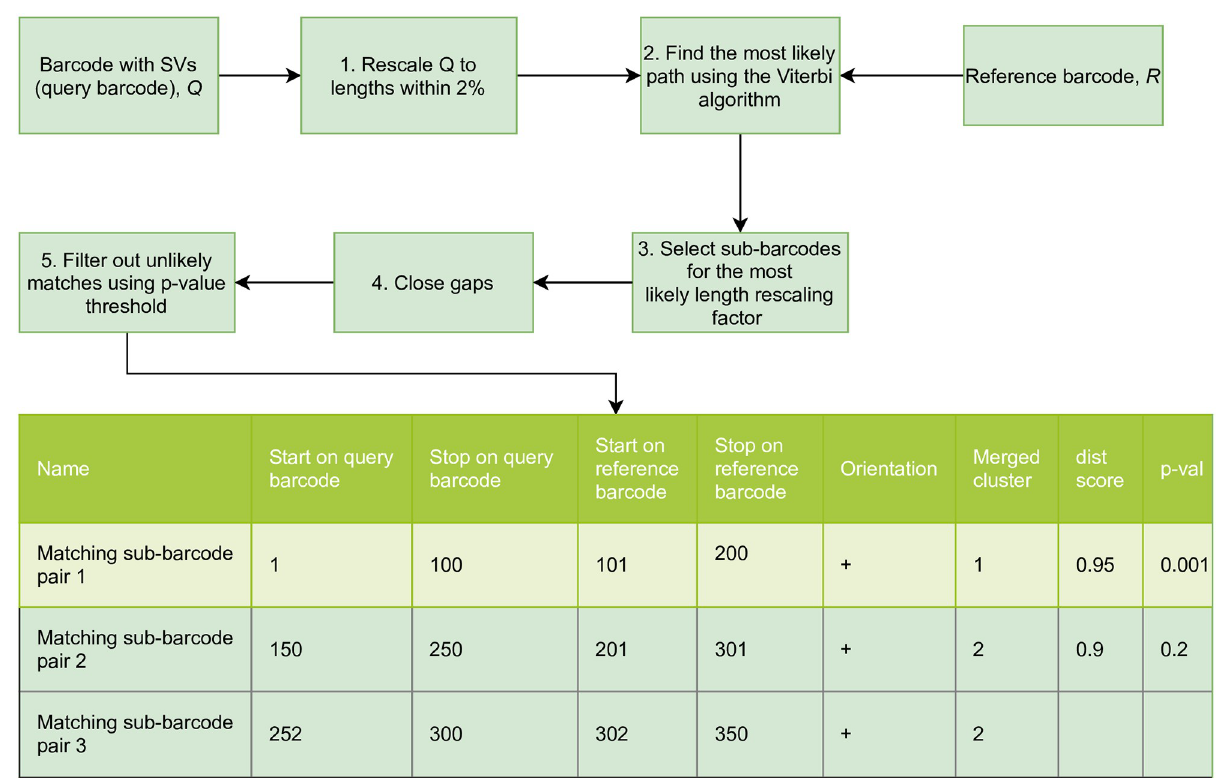
Fig 2. Hidden Markov Model (HMM) approach for detecting SVs in barcodes. The method consists of 5 steps: 1) The length of the query barcode (barcode with SVs) is rescaled based on a range of length re-scaling factors around an initial estimate of length re-scaling factor. 2) The most likely path through the states, which defines the final alignment, is found using Viterbi algorithm. This path corresponds to pairs of indices of sub-barcodes between query and reference barcodes. 3) Sub-barcodes based on the most likely length re-scaling factor are selected. 4) Gaps and overlaps that are separated by a distance no more than g are closed (sub-barcodes merged). 5) Unlikely matches are filtered out using a p-value threshold p thresh . Finally, the output table with the detected matching sub-barcode pairs is given.